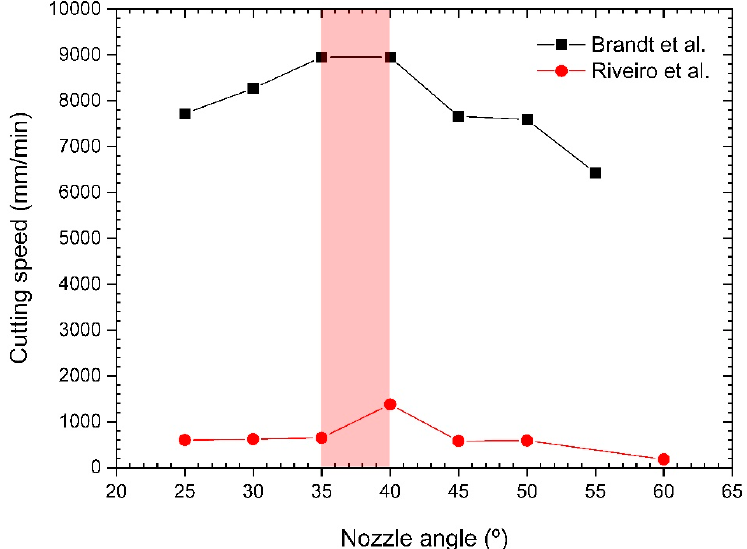
Figure 19. Maximum cutting speed as a function of the nozzle angle for a sonic exit nozzle [89] and for a supersonic exit nozzle [91] during CO 2 laser cutting of 3 mm mild steel and 3 mm Al-2024-T3 alloy respectively. Optimum nozzle angles range from 35 ◦ to 40 ◦ with regard to the laser beam.